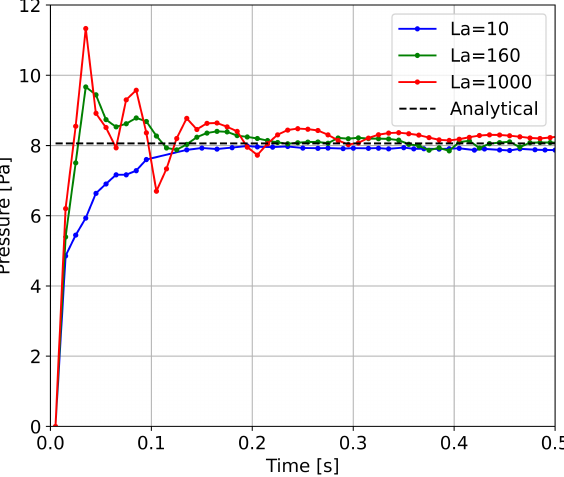
Figure 4. Mid-plane pressure field at t = 1 s for ( a ) La = 10, ( b ) La = 160, and ( c ) La = 1000. Figure 4a to Figure 4c show the mid-plane pressure field at time t = 1 s for all